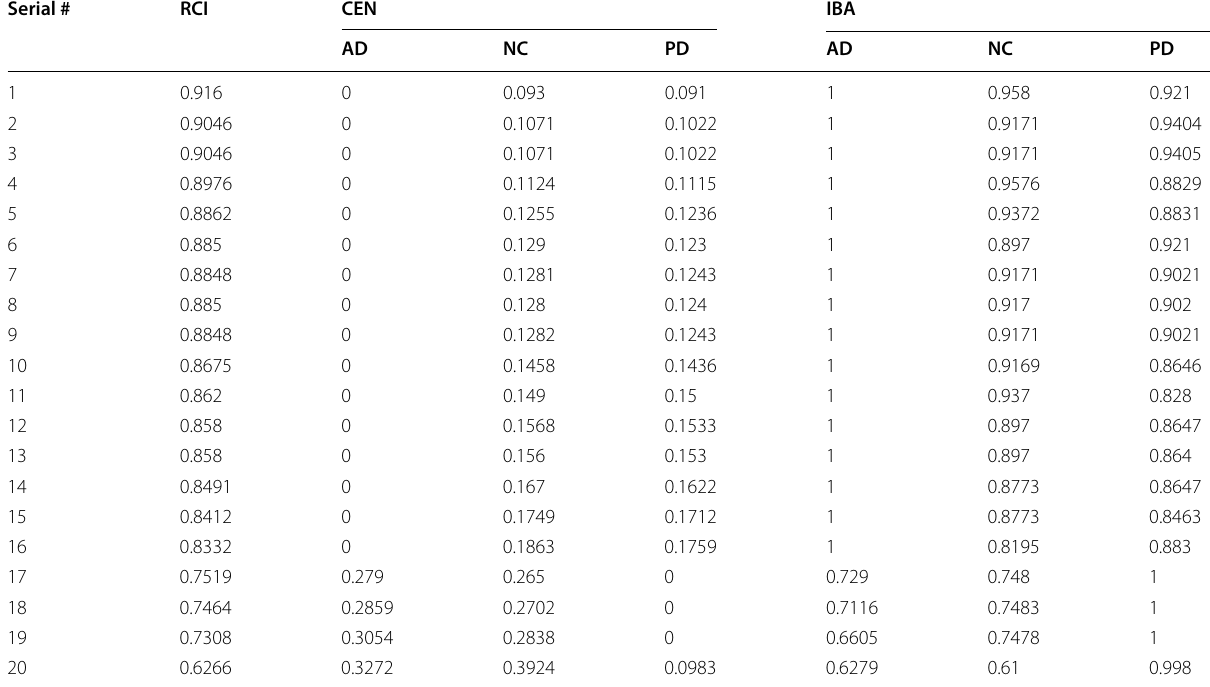
Table 5 RCI, CEN and IBA performance metrics for the